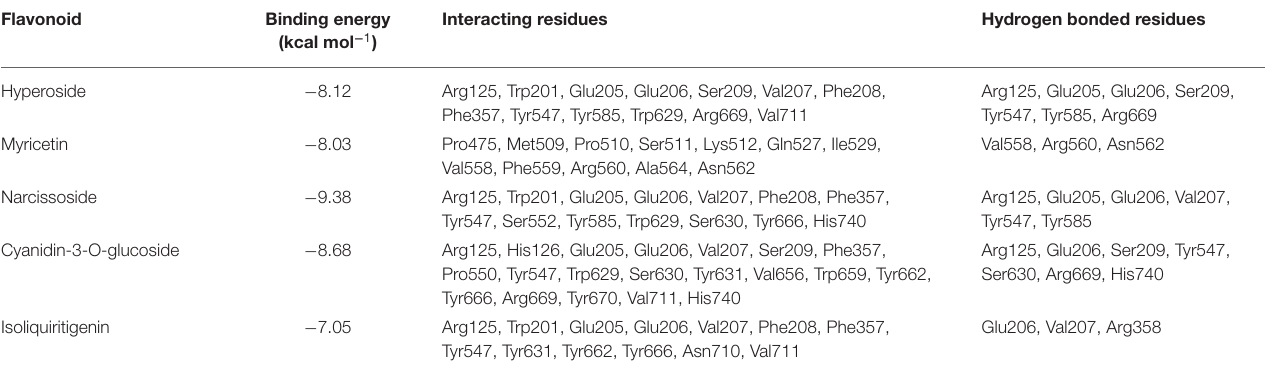
TABLE 4 | Docking results of hyperoside, myricetin, narcissoside, cyanidin 3-O-glucoside, and isoliquiritigenin with DPP-4. Flavonoid Binding energy (kcal mol − 1